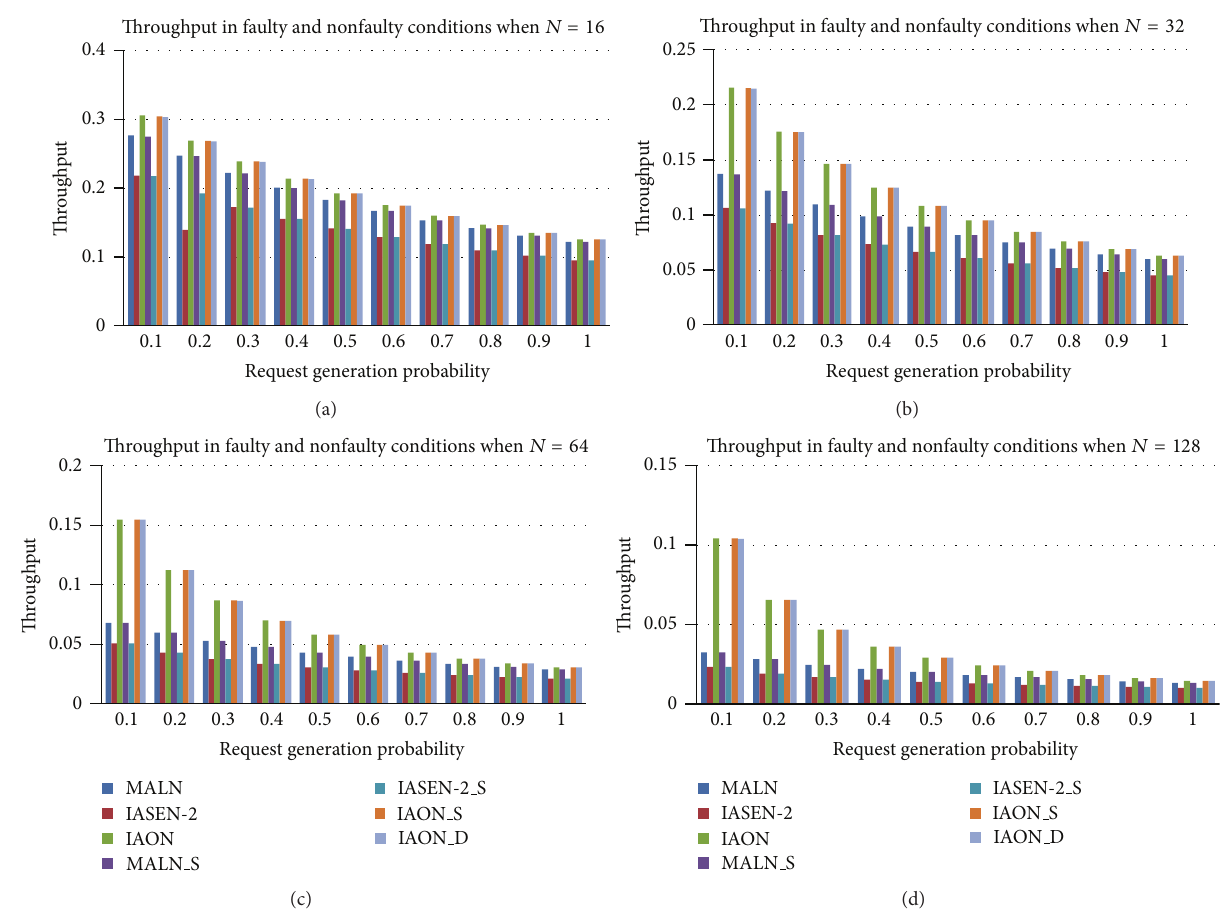
Figure 11: The throughput of MALN, IASEN-2, and IAON in faulty and nonfaulty cases, when the network sizes are 16, 32, 64, and 128